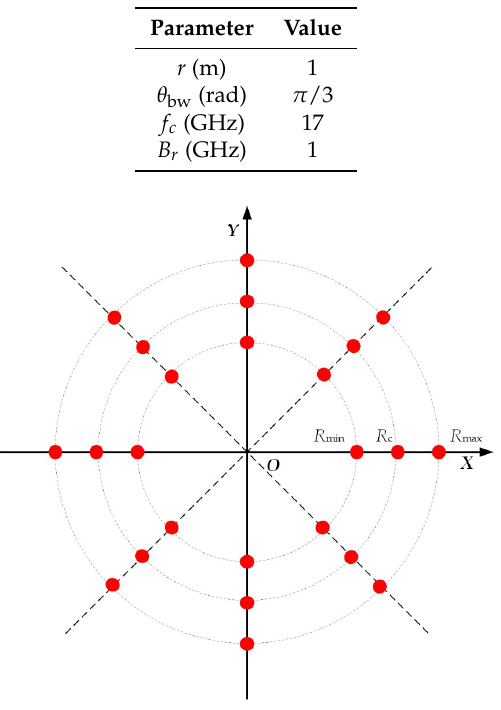
Table 1. Experimental parameters.